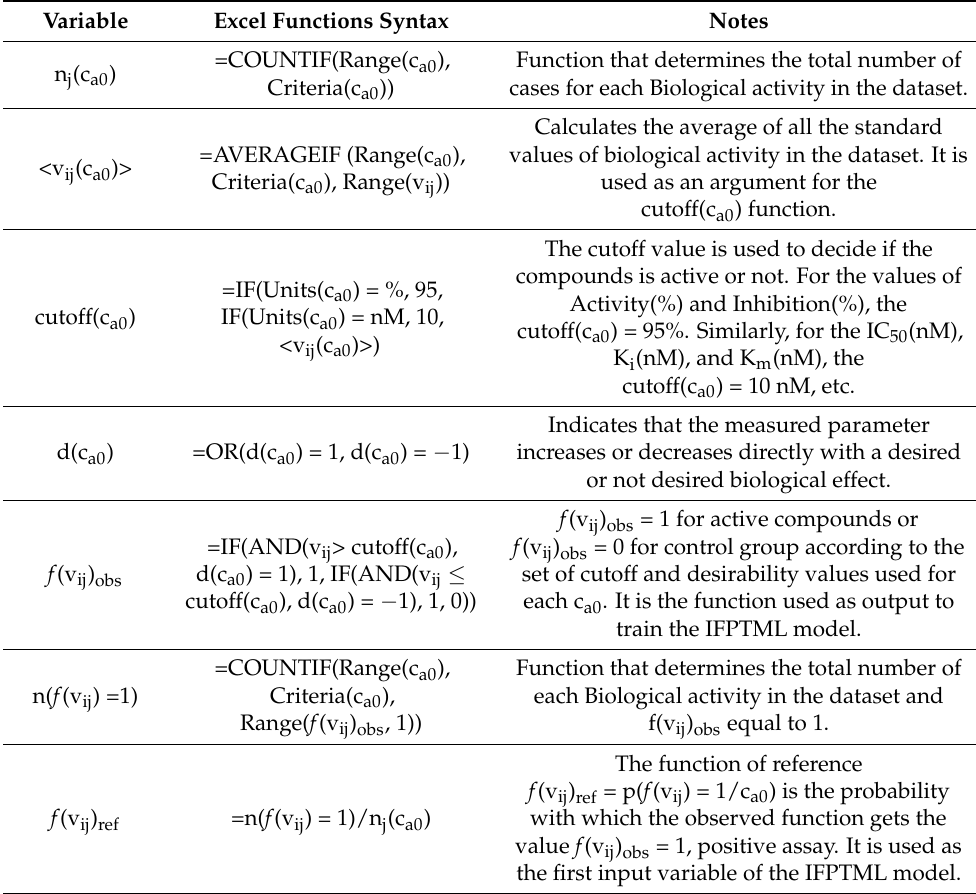
Table 6. More relevant functions used in the data pre-processing